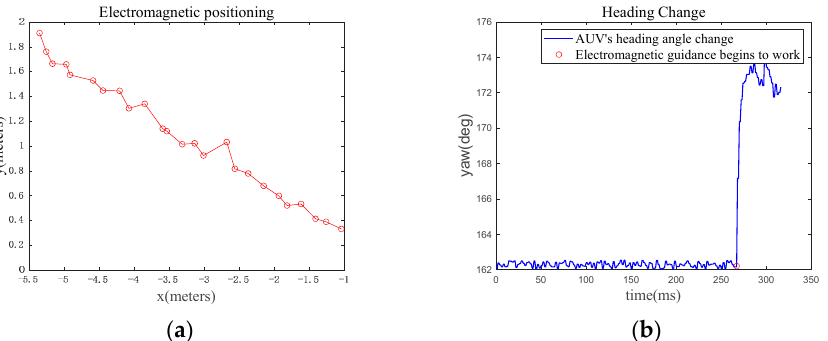
Figure 21. The trajectory of the electromagnetic positioning ( x , y ) ( a ) and AUV’s yaw angle ( b ) during AUV terminal docking.